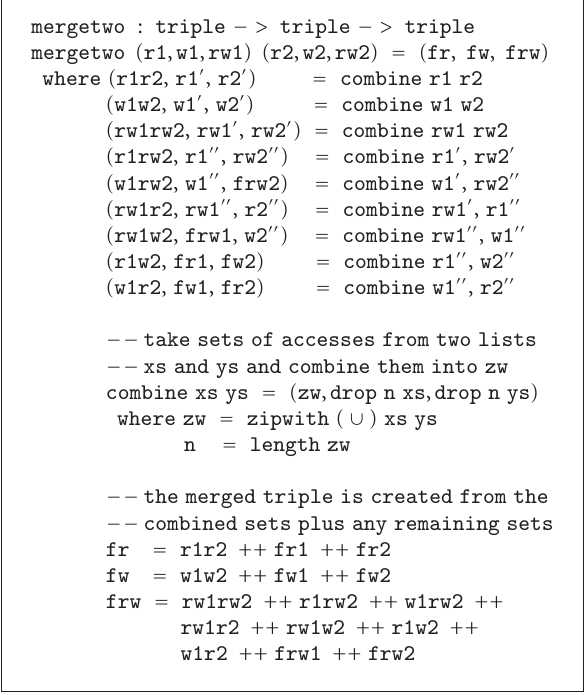
Table 2: Steps showing progress of access